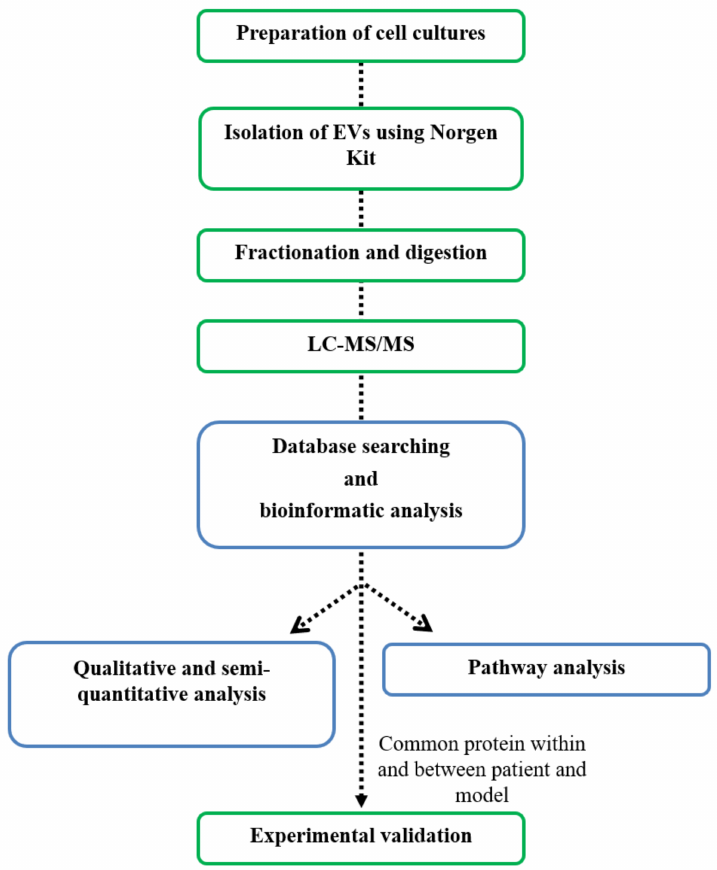
Figure 1. Workflow followed for this study. Schematic representation of the experimental phase (green box) and the computational phase (blue box). Arrows represent outputs.